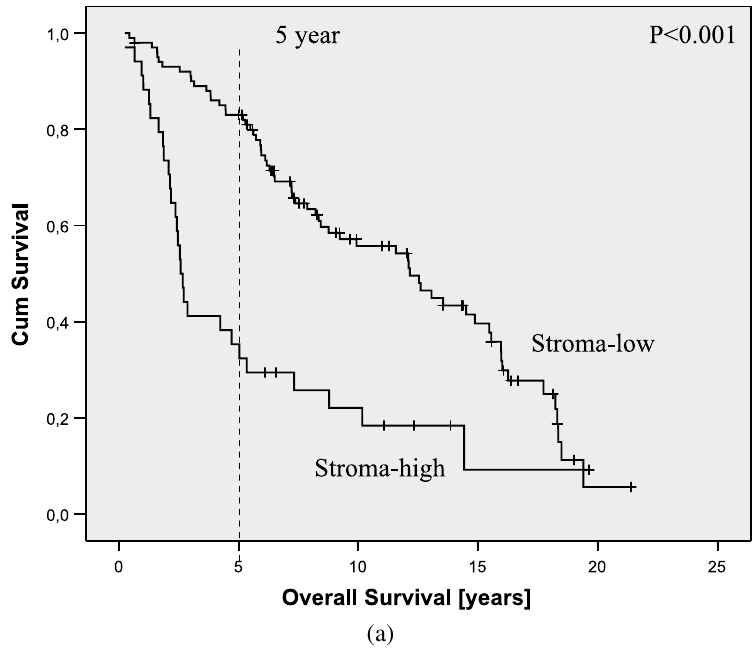
Fig. 1. Kaplan–Meier survival curves for stroma-high and stroma-low patients: (a) OS, (b) DFS, (c) MFS. Notably, the mean age of the analyzed patient group was 68.2 years with a mean follow-up time of 10.9 years. As some patients have a follow-up period of 20 years the full survival time was